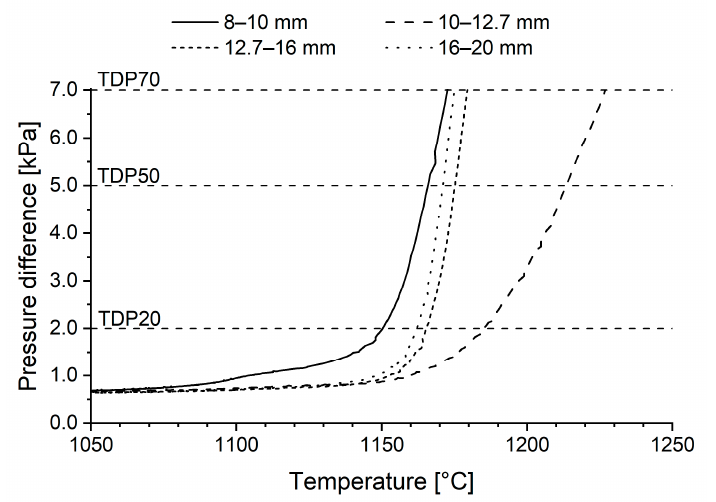
Figure 7. Evolutions of pressure difference in the reduction-softening tests.